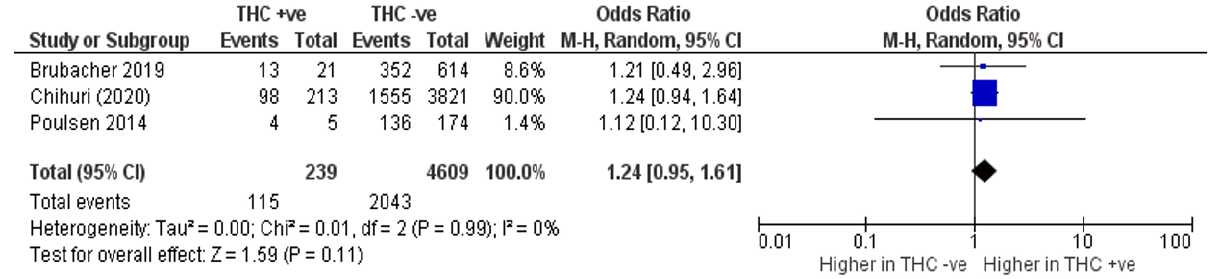
Figure 4. Pooled odds ratio (95% CI) of culpability risk associated with THC exposure in older drivers over the age of 50 [34 – 36].